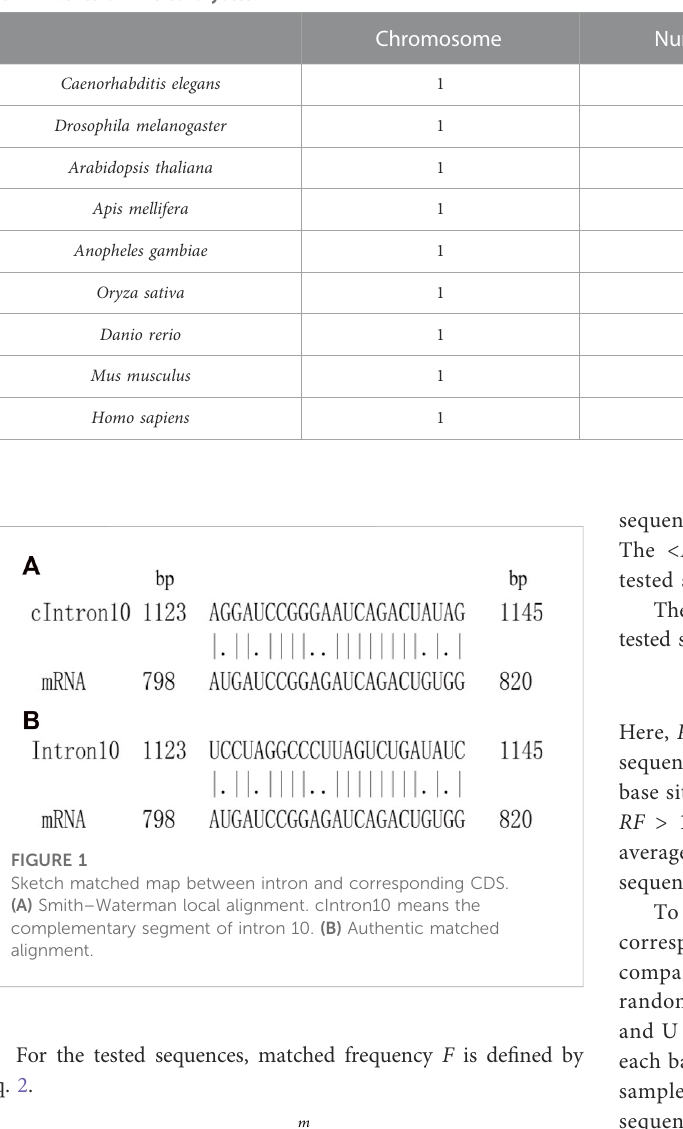
TABLE 1 Genes of nine eukaryotes.